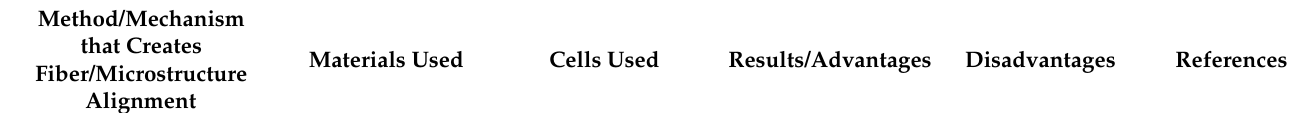
Table 5. Summary of other unique fabrication methods to produce highly aligned scaffolds for